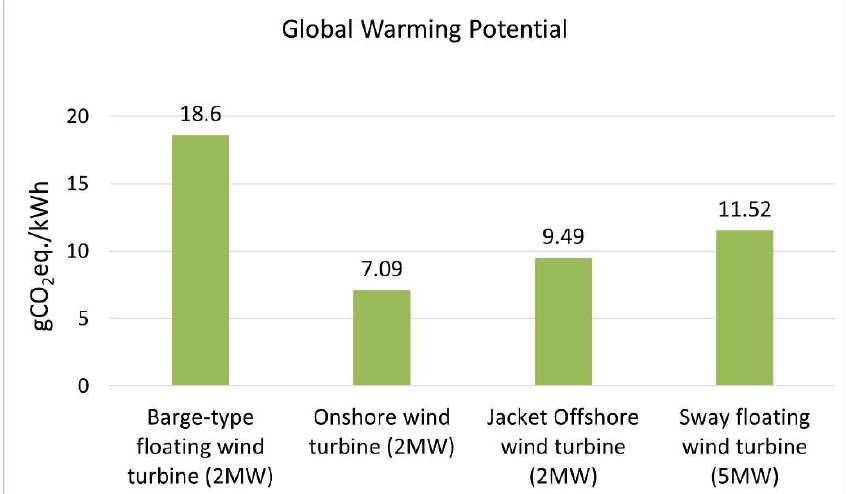
Figure 7. Total global warming potential for floating, onshore, and offshore wind turbine.